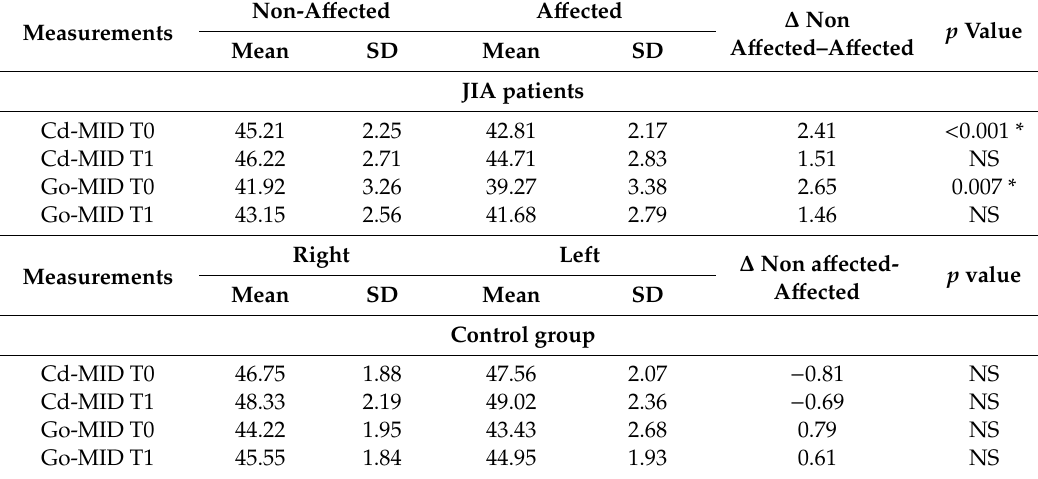
Table 5. Mean, standard deviation (S.D.) and comparisons of pre-treatment (T0) and post-treatment (T1) values with independent t -test between Non-a ff ected and A ff ected side in JIA group and between right and left side in non-JIA control